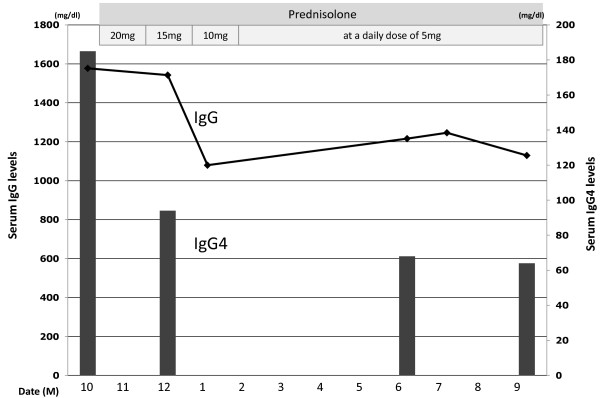
Laboratory data before and after treatment with oral prednisolone. Administration at a daily dose of 20 mg was initiated. The serum IgG4 levels decreased dramatically. The laboratory data initially showed an IgG4 level of 94 mg/dL. After nine months this had decreased to 64 mg/dL.